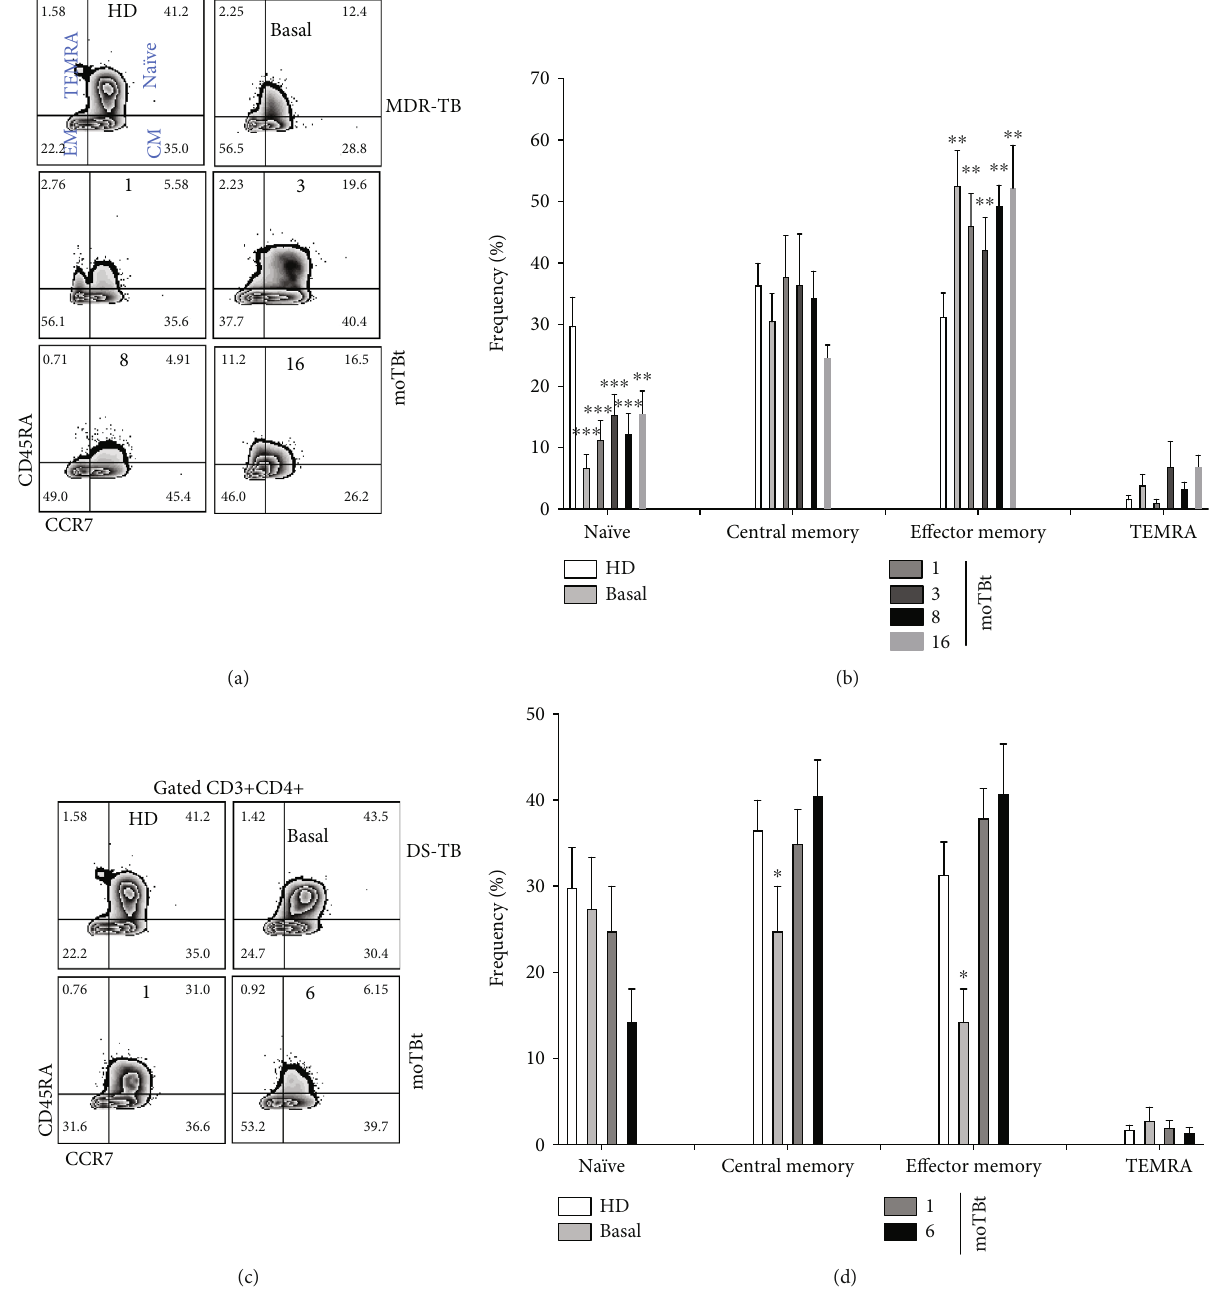
Figure 4: Kinetics of CD4+ T cell subpopulations in MDR-TB patients. Representative zebra plots showing the strategy of analysis used to enumerate naïve (CD45RA+CCR7+), central memory (CM, CD45RA-CCR7+), e ff ector memory (EM, CD45RA-CCR7-), and TEMRA (CD45RA+CCR7-) CD3+CD4+ T cells in peripheral blood mononuclear cells (PBMCs) from multidrug-resistant (MDR-TB) and drug- sensitive (DS-TB) patients (a and c, respectively). (b) Frequency of CD3+CD4+ T cell subpopulations in MDR-TB patients (HD: n = 6 , MDR-TB: basal, 1, and 3 moTBt n = 10 , 8 moTBt n = 8 , and 16 moTBt n = 7 ). (d) Frequency of CD3+CD4+ T cell subpopulations in DS- TB patients (HD n = 6 , DS-TB: basal and 1 moTBt n = 10 , and 6 moTBt n = 8 ). Bar graphs depict means ± standard errorof themean ð SEM Þ . Di ff erences between patient groups and HD at each time point were analyzed using multiple Student ’ s t -test corrected for